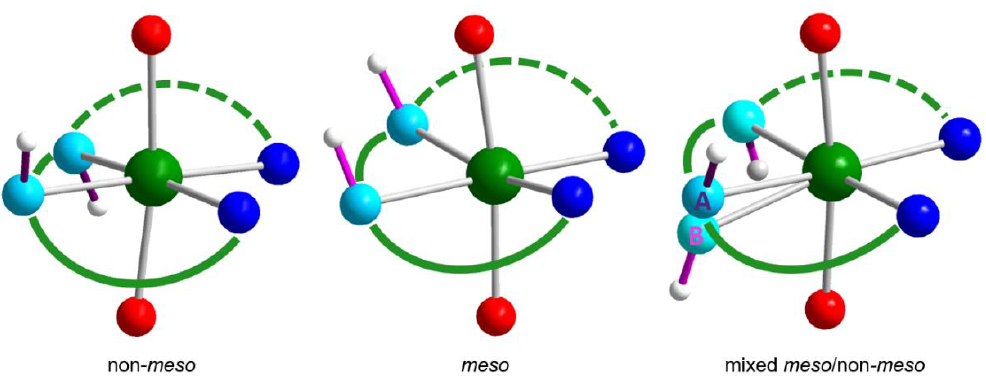
Figure 2. Hydrogen atoms at the amine nitrogen of the R-Sal 2 333 backbone, forming the non -meso Type A form ( Left ) and meso form ( Middle ) of the ligand. Co-crystallization of both modes ( Right ) was observed in the tetraphenylborate complex 2 and this crystallization mode was termed Type B.